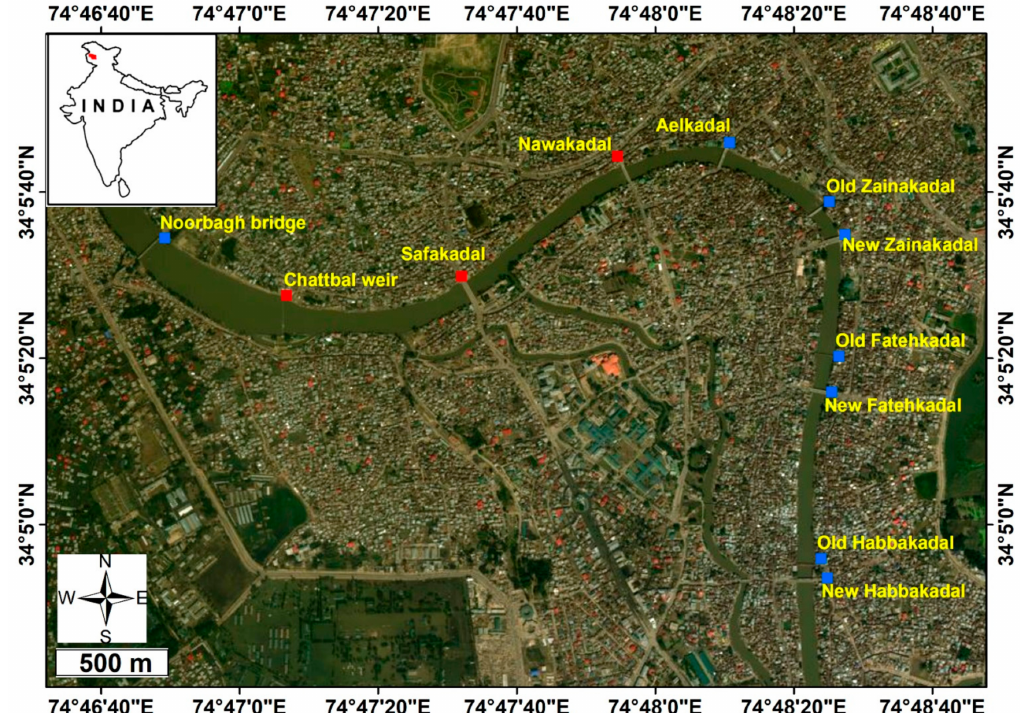
Figure 1. Location of the affected stretch of the Jhelum River, indicated by red dots. Blue dots indicate prominent locations along the unaffected portion of Jhelum River, Srinagar City. Background image: IKONOS GeoEye, dated 21 September